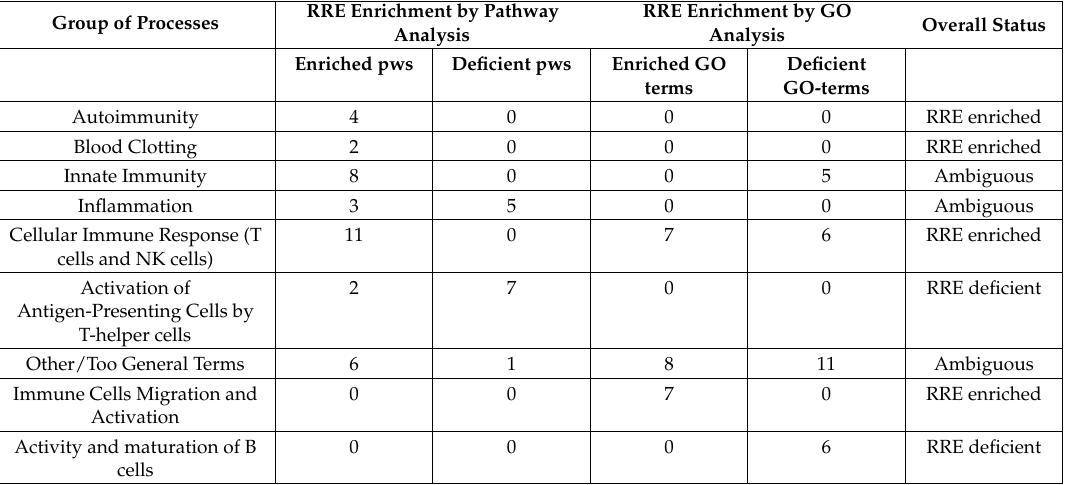
Table 4. RRE-enriched and deficient immunity-linked processes according to Gene Ontology (GO) and molecular pathway analysis ( all REs).